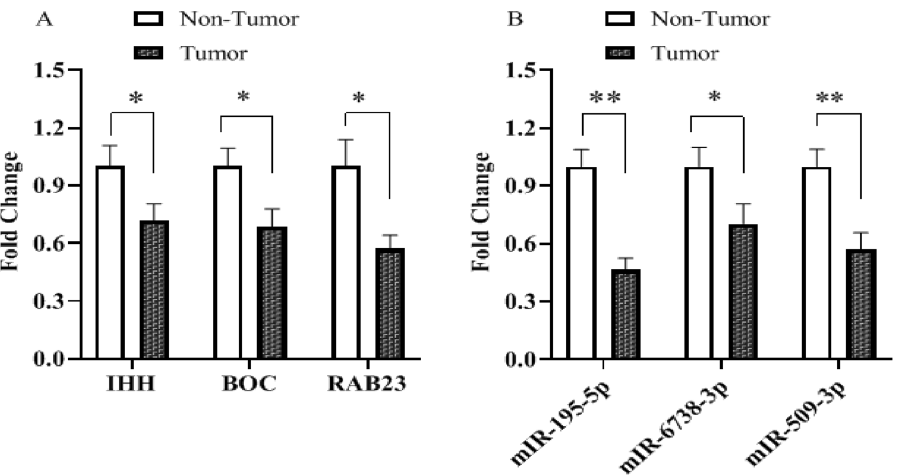
Figure 1. The expression level of Shh genes and their associated miRNAs. ( A ): IHH , BOC , and RAB23 ; ( B ) miR-195-5p , miR-6738-3p , and miR-509-3-5p in tumoral tissues in comparison with their adjacent non-tumoral counterparts. * and ** indicate significant difference P < 0.05 and P < 0.01,